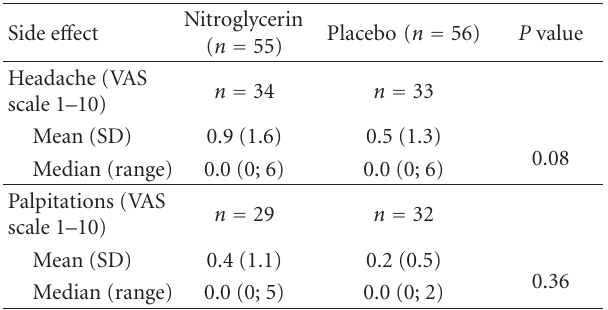
Intention to treat group, ITT: all randomized patients, including 4 patients who did not receive study medication and 2 patients who only received 0.5mg